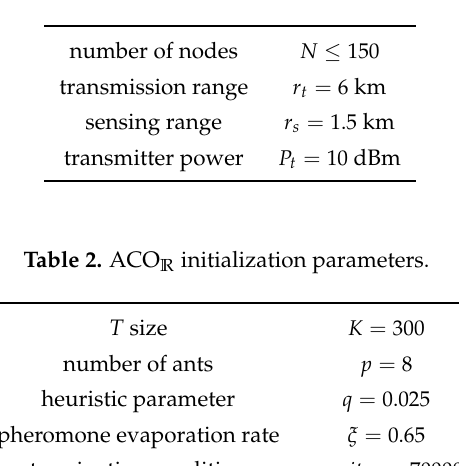
Table 1. Technical parameters.